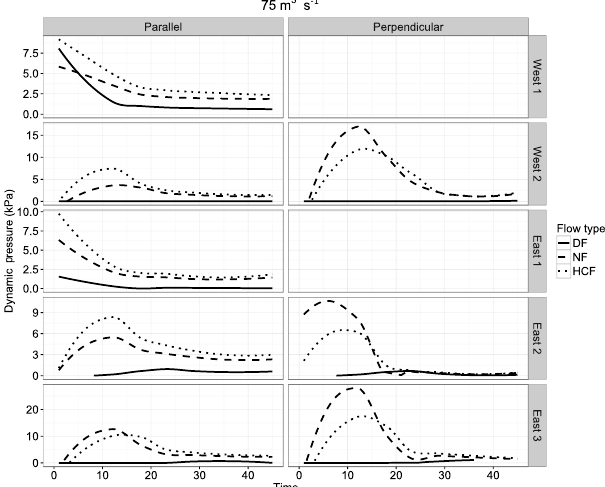
Figure 8. Mean normal pressures applied to each city block in the perpendicular and parallel orientations for a 75m 3 s − 1